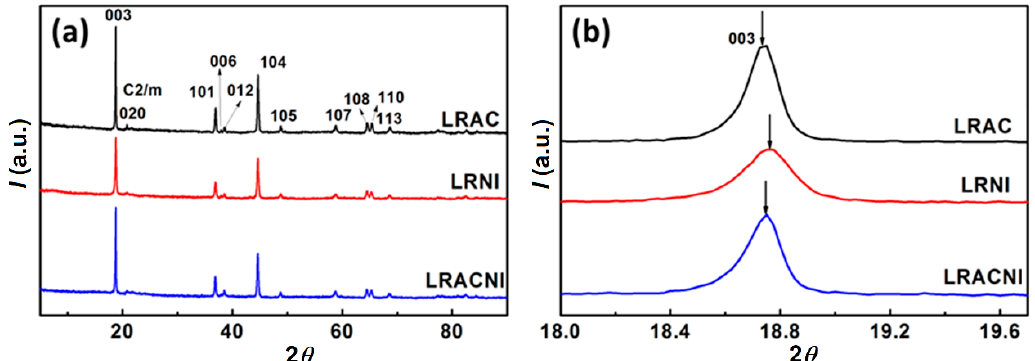
Figure 5. XRD patterns of LRAC, LRNI, and LRACNI in the 2 θ range of ( a ) 5°–90° and ( b ) 18°–19.7° for fine structures.